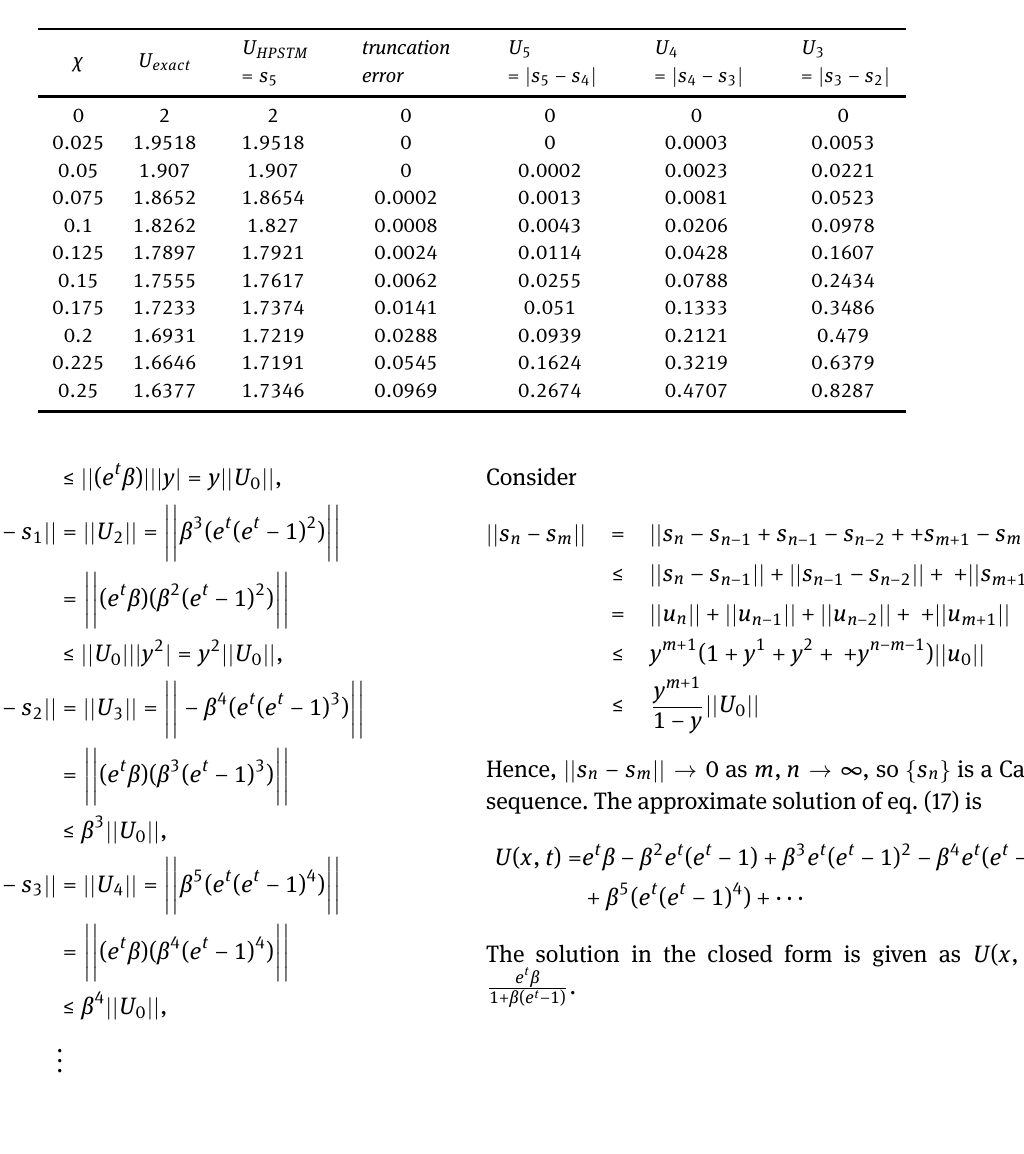
Table 2: Numerical solution when β =